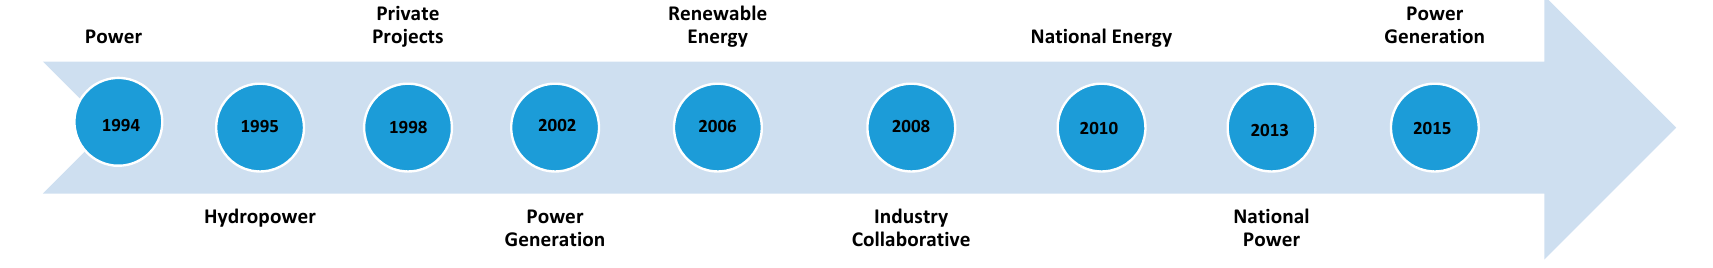
Figure 9. Timeline of Pakistan’s energy policies showing various accomplishments.